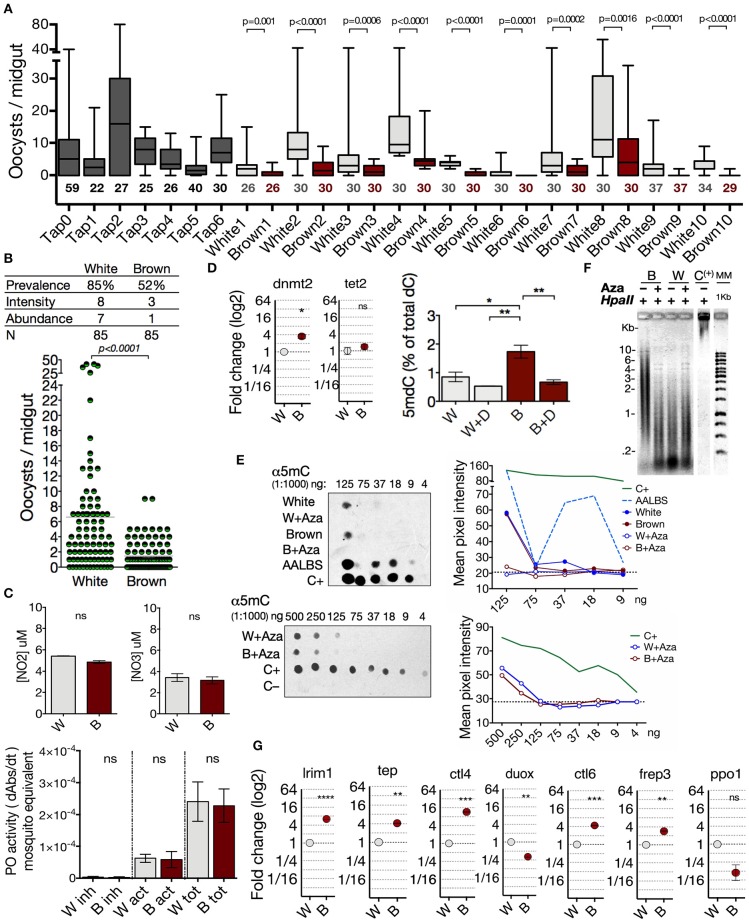
Anopheles albimanus phenotypes are different in gDNA methylation status, transcriptional profile and susceptibility to Plasmodium. (A) Intergenerational follow-up of the infection abundance in 7 generations of the parental Tap strain and 10 generations of the Brown and White derived phenotypes. Numbers below the boxes indicate the number of mosquitoes sampled. Data was analyzed by Mann-Whitney test. (B) Infection parameters in the White-susceptible and Brown-resistant phenotypes. Results of three independent experiments analyzed by Mann-Whitney test. (C) Measurement of nitric oxide production, and phenoloxidase activity in the White (W) and Brown (B) phenotypes. Inhibited enzyme (inh), active enzyme (act) and total enzyme (tot). Mean ± SEM of three independent experiments analyzed by two-tailed t test. (D) Basal midgut expression of dnmt2 and tet2 in Brown (B) and White (W) mosquitoes obtained by qPCR and the percentage of global 5-methyl-2-deoxycytidine (5mdC) in midgut gDNA of both phenotypes treated with 50 μM of decitabine (W+D and B+D). Determinations were obtained by HPLC (mean ± SEM of three independent experiments, analyzed by ANOVA and Tukey post-hoc test). (E) Effect of azacytidine on the amount of 5mC in midgut gDNA of the mosquito phenotypes determined by immunodetection. Mean pixel intensity of the dots is represented to the right of the blots. Hypermethylated DNA as positive control (C+), lambda phage as negative control (C–). AALBS is the A. albimanus LSB-AA695BB cell line. The numbers above the blots represent gDNA dilutions. (F) Midgut gDNA digestion with HpaII after azacytidine treatment in both phenotypes. (C+) = hypermethylated DNA. (G) Basal midgut expression of several immune anti-Plasmodium markers in the two phenotypes. Expression determined by qPCR and relative to White mosquito's expression. Means ± SEM of three independent experiments analyzed by two-tailed t test. Asterisks represent the P value as follows: *P < 0.05, **P < 0.01, ***P < 0.001, ****P < 0.0001.